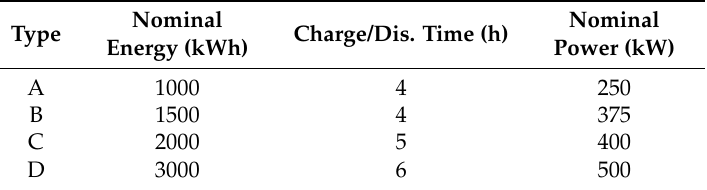
Table 4. Type of batteries connected in the 33- and 69-node test